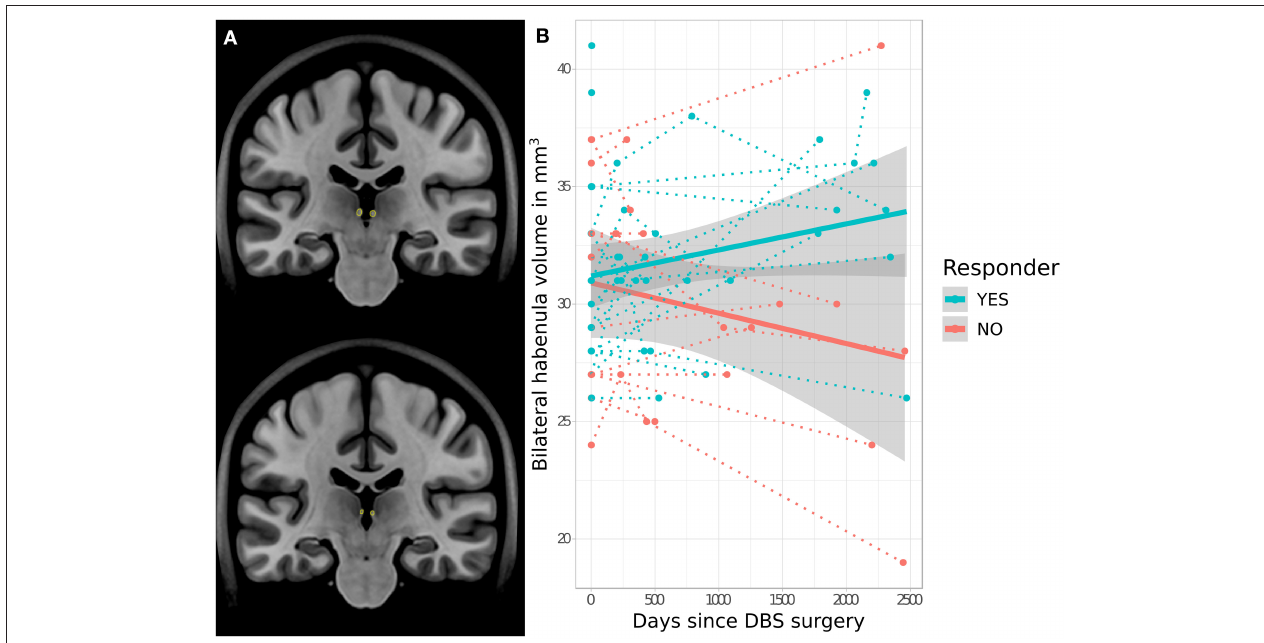
FIGURE 2 | Response-related trajectories of change in habenular volume over time following SCC-DBS. (A) Outline of the habenula—as per automated MAGeT segmentation—shown on two different coronal slices of the MNI152 template brain for illustrative purposes. (B) Changes in bilateral habenula volume over time following SCC-DBS surgery are shown for each patient (follow-up is cut off at 2,500 days post-surgery for visualization purposes, although some post-operative scans were acquired at later timepoints). The dotted lines indicate the change in habenular volume over time in individual patients, while the thick solid lines indicate the estimated change in habenular volume over time for each cohort overall. The gray shaded zones surrounding the solid lines denote the 95% confidence interval. A significant difference in trajectory of change was found in responders ( ≥ 50% HAMD improvement) compared to non-responders: habenula volume decreased over time in non-responders but increased in responders ( t = 2.4, p < 0.021 for interaction of time and response status). DBS : deep brain stimulation; HAMD-17 : 17-item Hamilton rating scale for depression; MNI , Montreal Neurological Institute; SCC , subcallosal cingulate